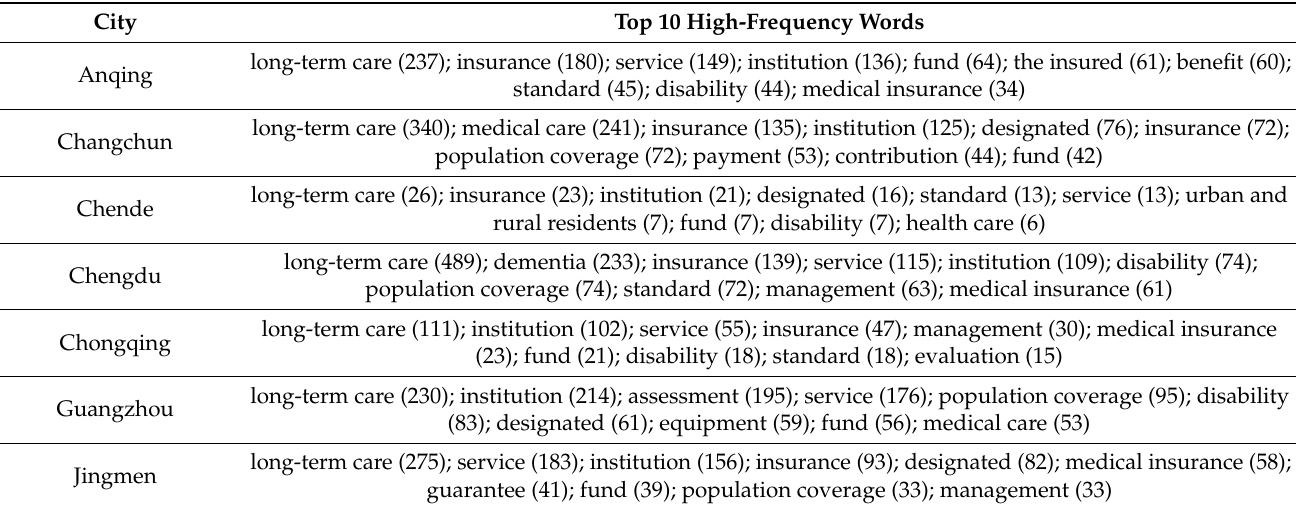
Table A3. The top 10 high-frequency words in the LTCI policy documents of 14 pilot cities. Top 10 High-Frequency